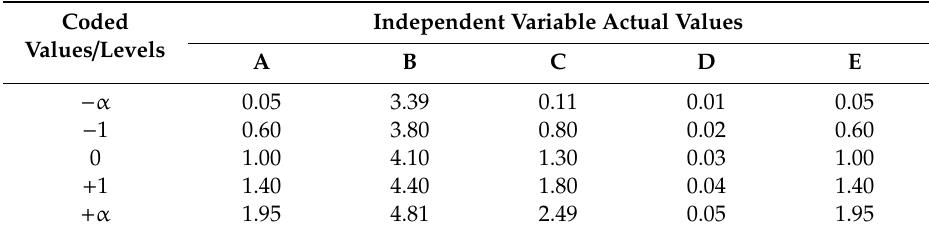
Table 7. The CCD matrix design of five selected nutritional factors in modified BH